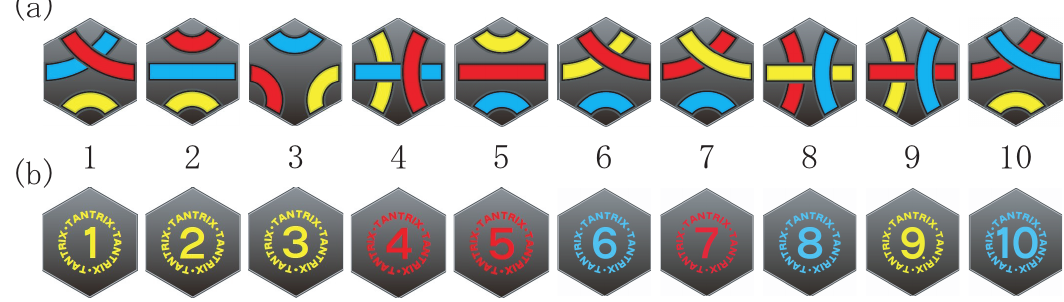
Figure 1. ( a ) Tops of 10 sorts of tiles (with their orientations 1), and ( b ) their corresponding backs.